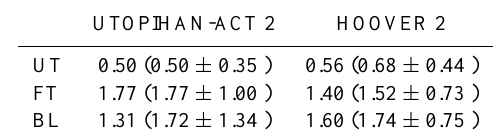
Fig. 5. Comparison of the TOPSE (March/April 2000), INTEX- NA (July 2004), UTOPIHAN 2 (July 2003), UTOPIHAN 3 (March 2004), HOOVER 1 (October 2006) and HOOVER 2 (July 2007) measurement campaigns. The median values for the respective alti- tude regions are shown as bars for H 2 O 2 , CH 3 OOH ∗ and HCHO.